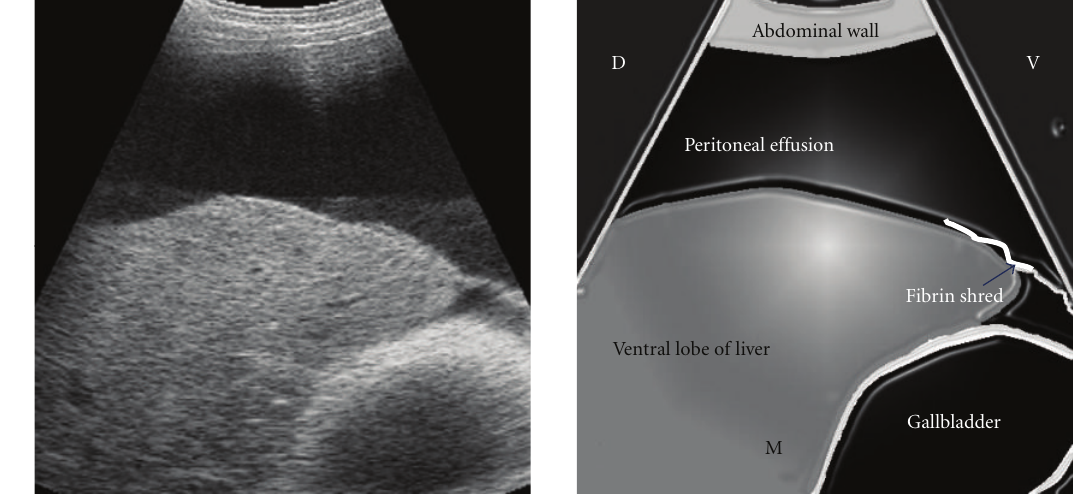
Figure 11: Ultrasonogram of the liver submerged in peritoneal e ff usion, with fibrin shred on its parietal surface, viewed from the right 11th ICS. ICS: intercostal space; D: dorsal; V: ventral; M: medial.